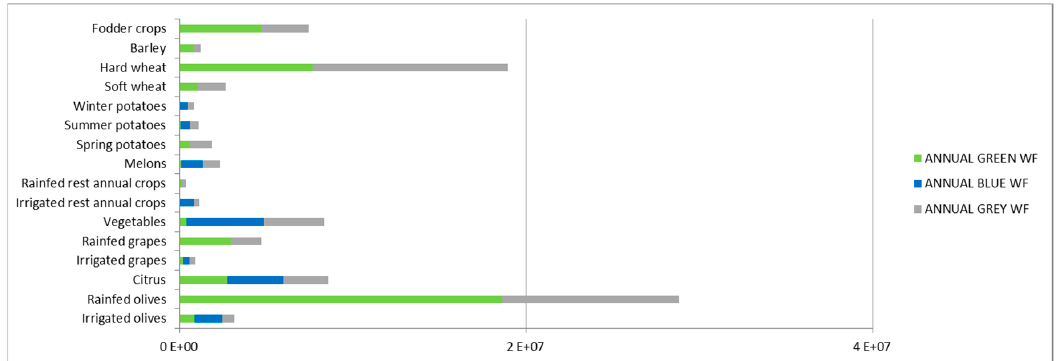
Figure 7. Total annual blue, green, and gray WF (m 3 year − 1 ) for Rhodes island per crop.